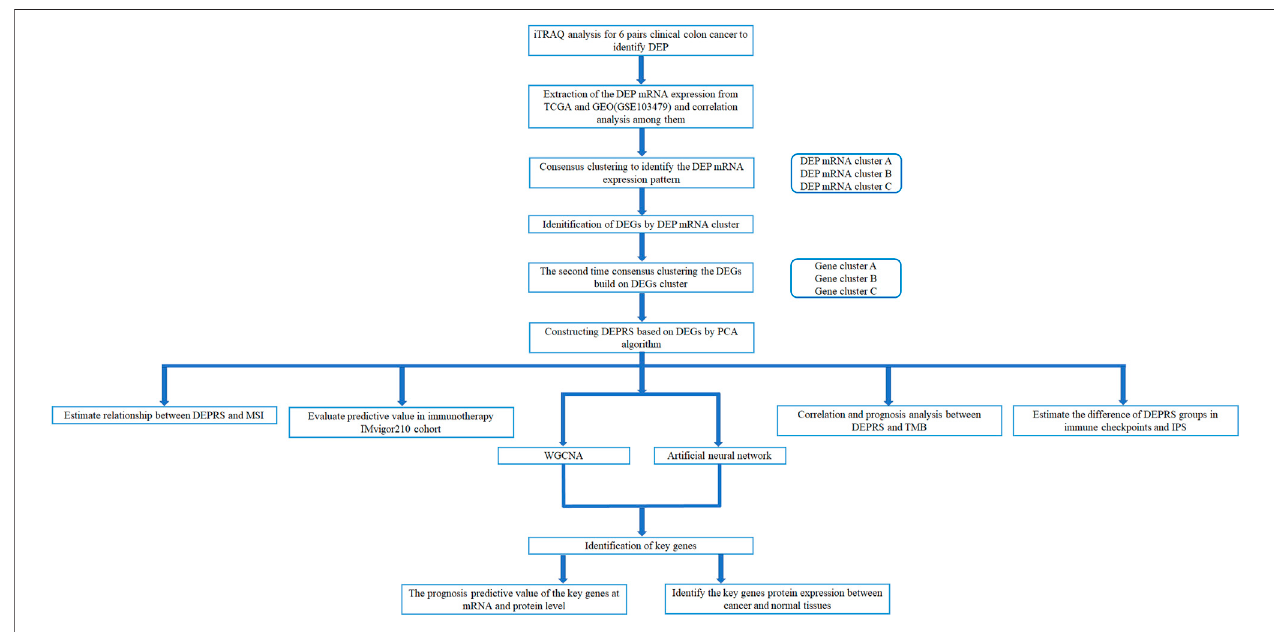
FIGURE 1 | Work fl ow of whole